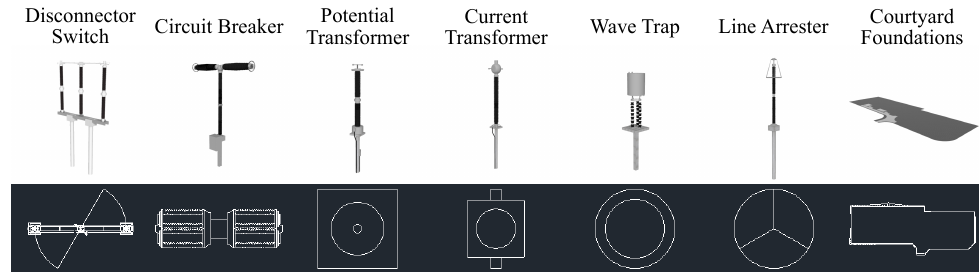
Figure 15. 3D models and symbols for the EPS constructed using 3Ds Max and the CAD